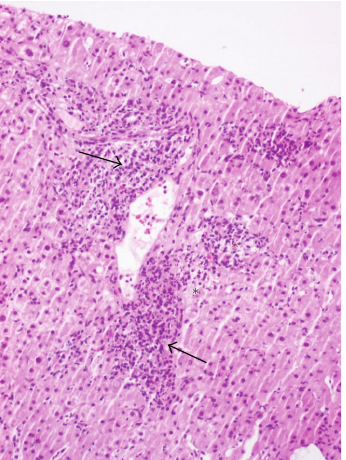
Figure 3: Liver biopsy. polymorphic inflammatory infiltrate of the portal spaces with extravasation into the hepatic parenchyma (black arrows), cell aggregates outlining granulomas (red star), focal necrosis of hepatocytes (black